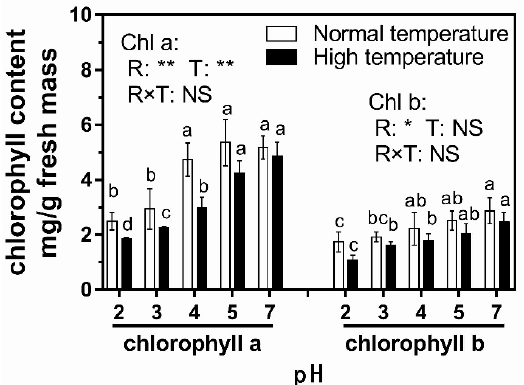
Figure 3. Effect of 7-day simulated acid rain exposure on the chlorophyll content of rice leaves. The same letter followed by the data in the same parameter indicates an insignificant difference among different treatments ( p < 0.05). The p values of two-way ANOVA for rain pH (R), temperature (T) and their interaction (R × T) are shown: **, p ≤ 0.01; *, p ≤ 0.01; NS, p >